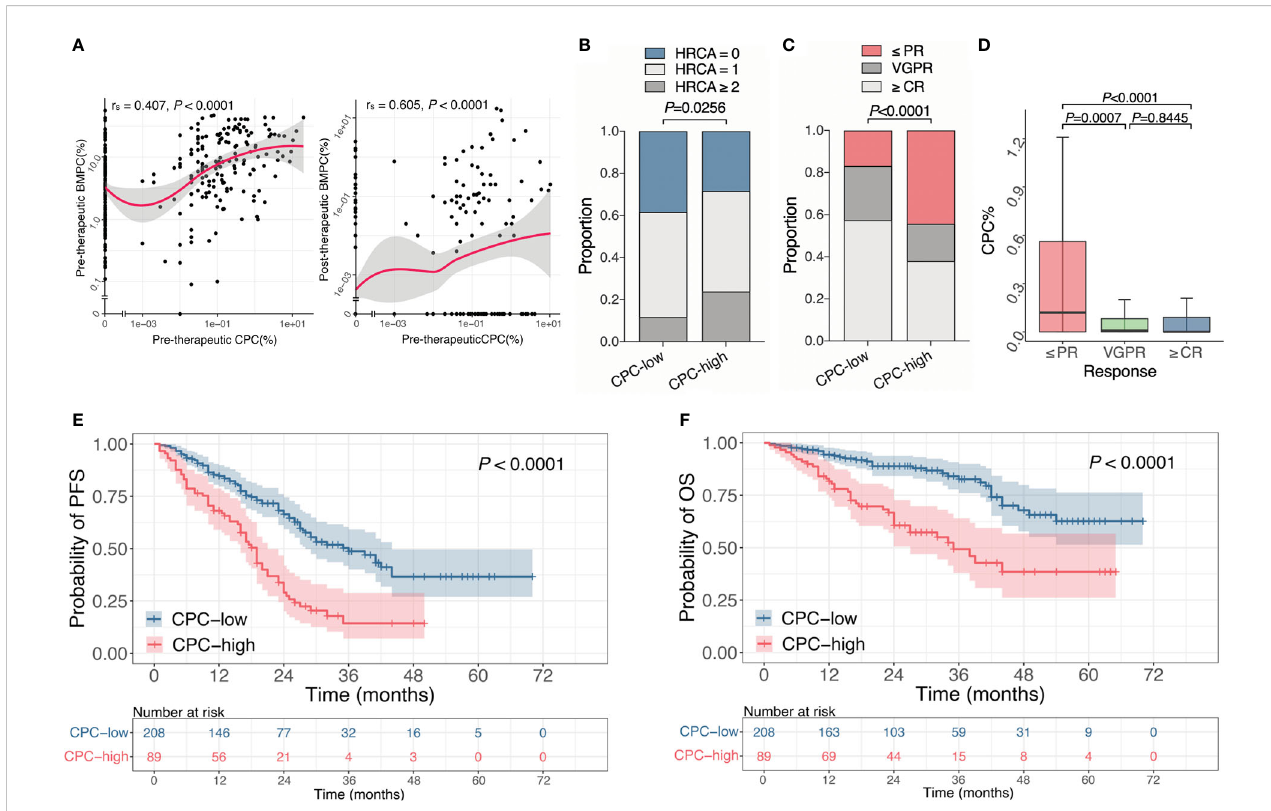
FIGURE 1 Association of CPC with clinical features, ef fi cacy and prognosis at initial diagnosis. (A) The Spearman ’ s correlation between pre-therapeutic CPC and BMPC before and after treatment. (B) Proportion of different HRCA counts in the CPC-low and -high group. (C) Response rates of patients after induction therapy in the CPC-low and -high group. (D) CPC levels in patients with different states of remission. (E, F) Kaplan-Meier curves for PFS (E) and OS (F) of patients with different CPC levels. CPC, circulating plasma cells; BMPC, bone marrow plasma cells; HRCA, high-risk chromosomal abnormality; PR, partial response; VGPR, very good partial response; CR, complete response; PFS, progression free survival; OS, overall